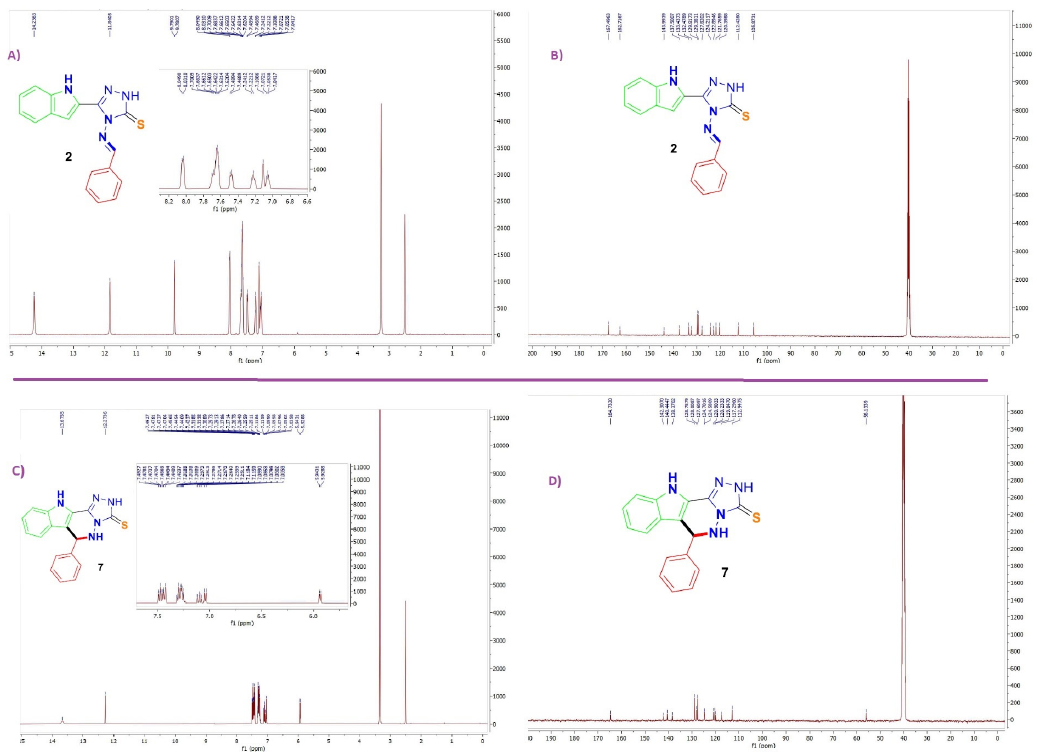
Figure 2. (A ) 1 H nuclear magnetic resonance (NMR) of 2 , ( B ) 13 C-NMR of 2 , ( C ) 1 H-NMR of 7 , and ( D ) 13 C-NMR of 7.